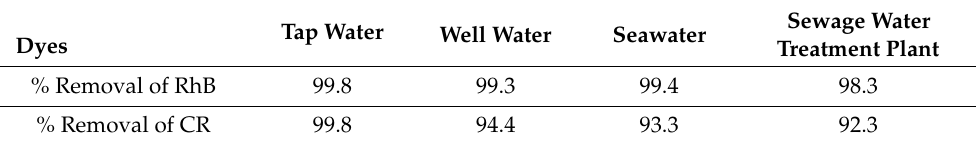
Table 5. Adsorptive percent removal of CR and RhB dyes from real water samples by PTFAC. Tap Water Well